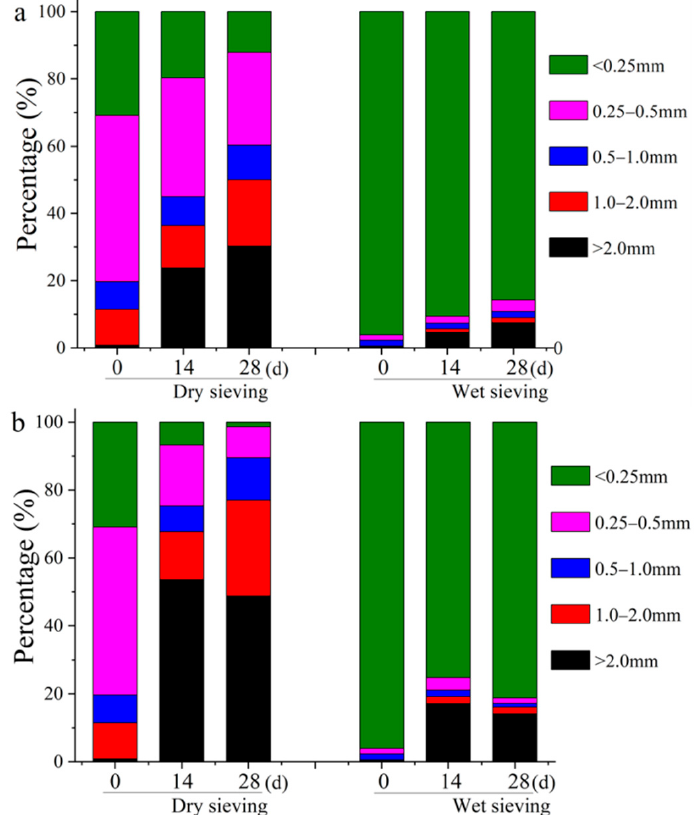
Figure 5. Aggregate size distribution of BR in CK ( a ) without the application of ZH-1; and RX ( b ) application of ZH-1 treatment ( n = 3).